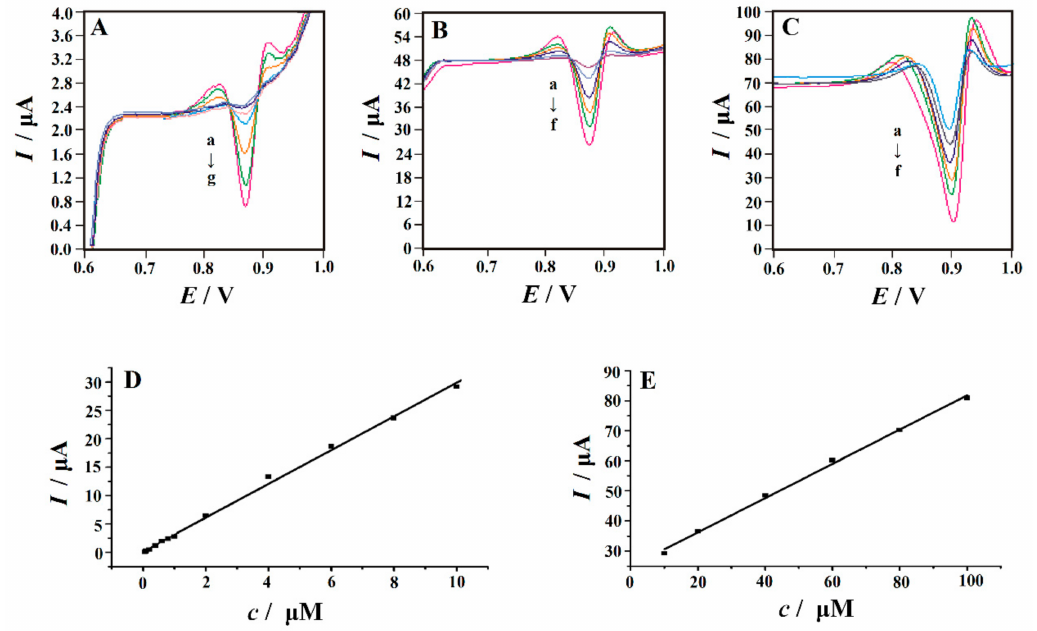
Figure 10. SDLSVs obtained at PVP-GR / GCE in 0.1 M PBS (pH 2.2) containing di ff erent concentrations of Trp. ( A ) from a to g is corresponding to 0.06, 0.08, 0.1, 0.2, 0.4, 0.6, 0.8 µ M; ( B ) from a to f is corresponding to 1.0, 2.0, 4.0, 6.0, 8.0, 10.0 µ M; ( C ) from a to f is corresponding to 10, 20, 40, 60, 80,